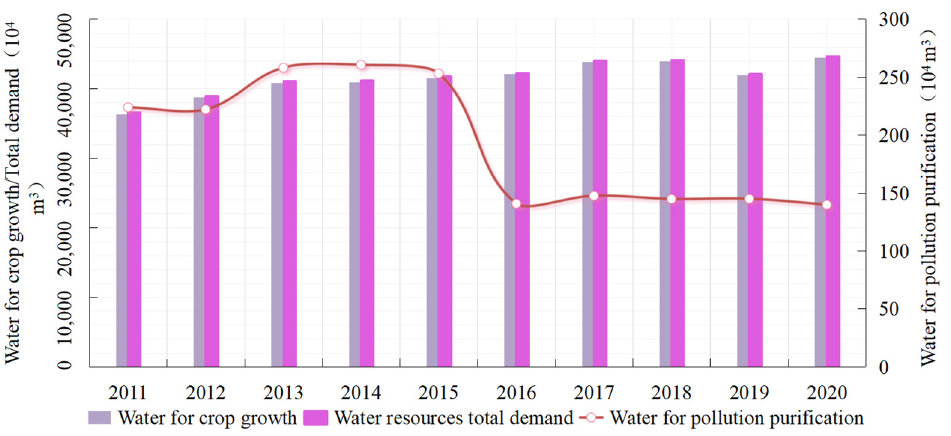
Figure 7. Changes in water demand for crop planting in Ganzhou district from 2011 to 2020.